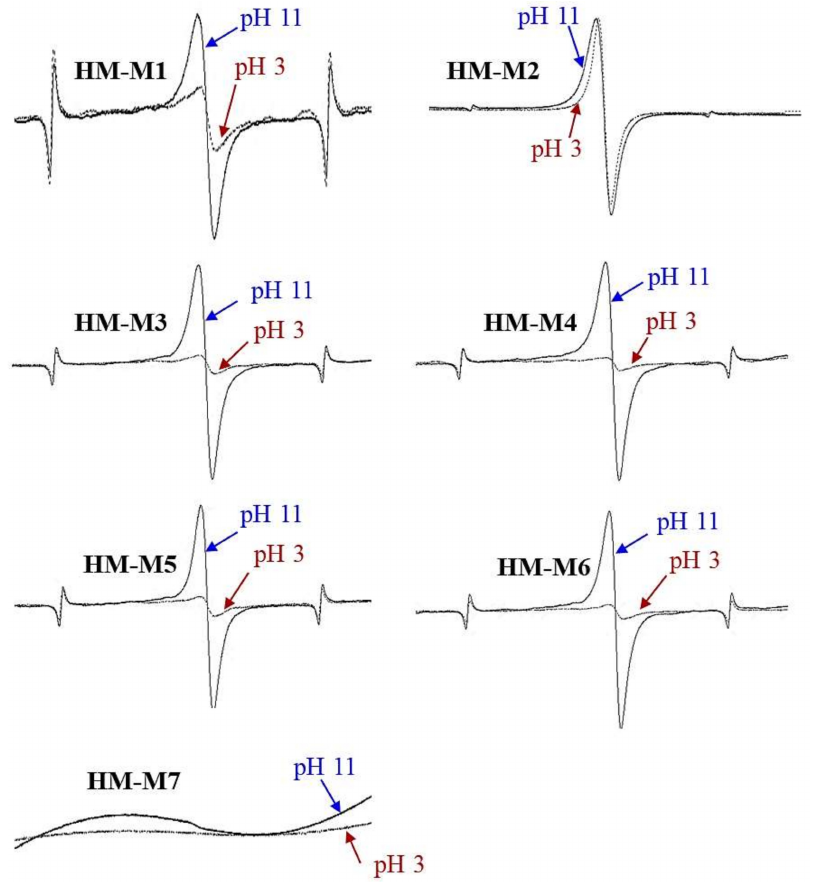
Figure 4. The electron spin resonance (ESR) spectra of humin (HM) isolated from the same Kamajima soil using different methods. Marker signals from the Mn calibration standard were located on two sides of organic radical peaks. No peaks were detected in